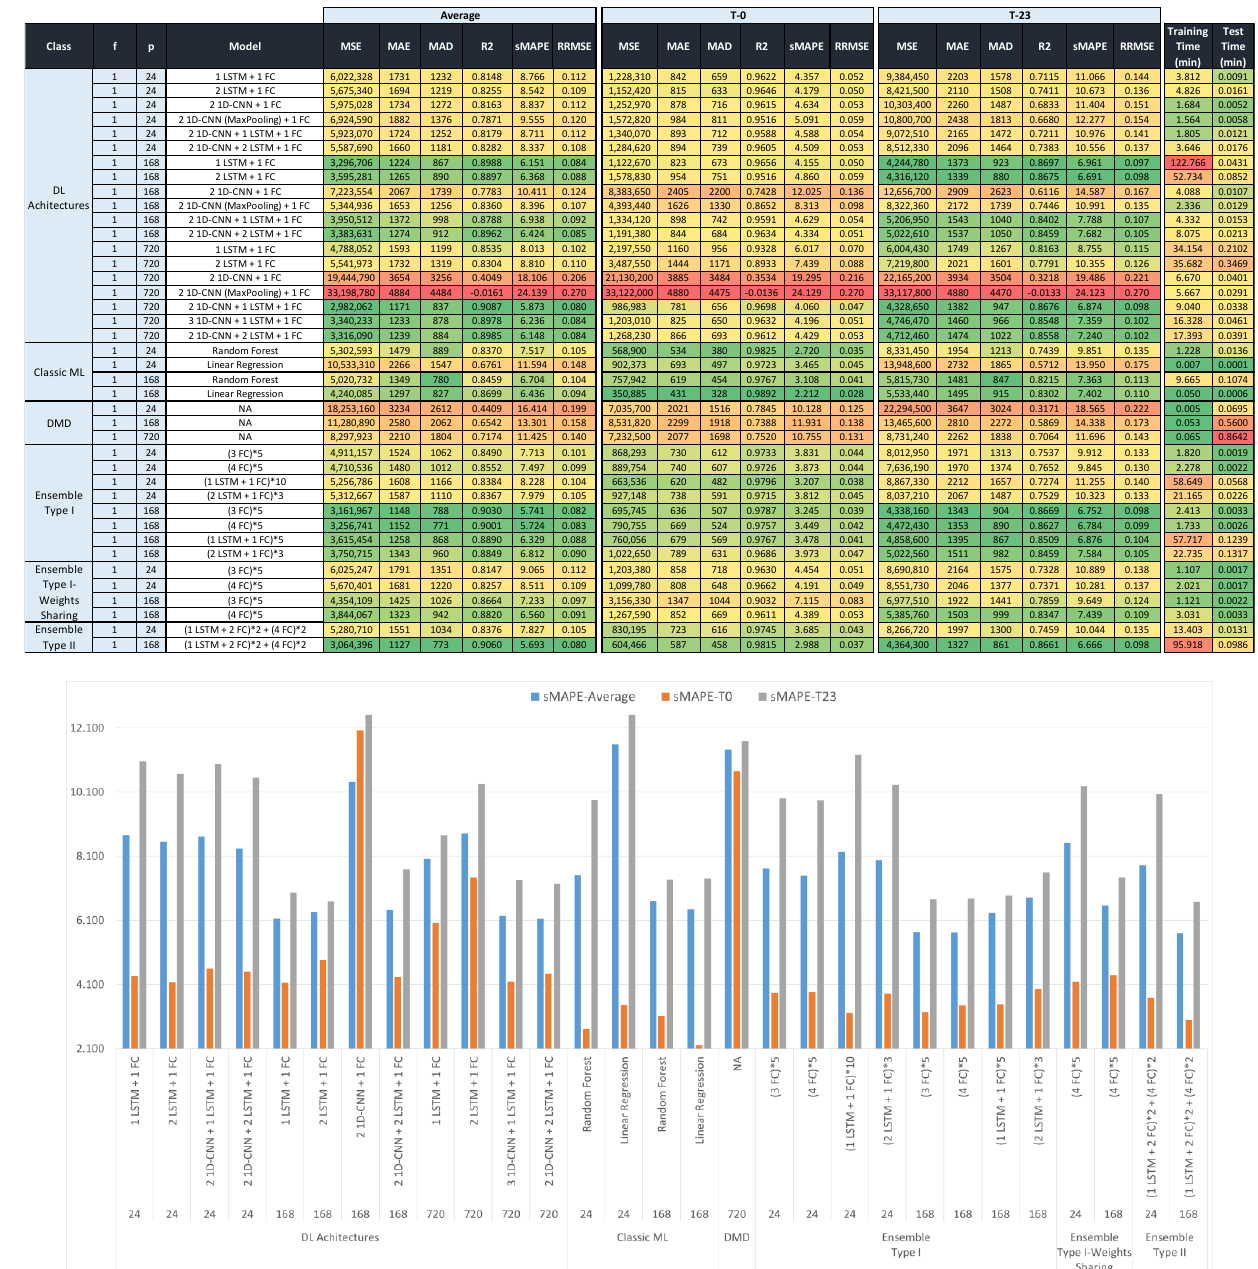
Figure 8. ( Upper section ): forecast metrics for the average, first (T-0), and last (T-23) predicted time-slots using DL, ML, and ensemble models for a fixed number of values per predictor ( 𝑓 = 1). The table is color-coded along columns with colors between red and green corresponding to the worst and best results, respectively. ( Lower section ): bar chart for sMAPE metrics for some of the best performing models from the upper table.